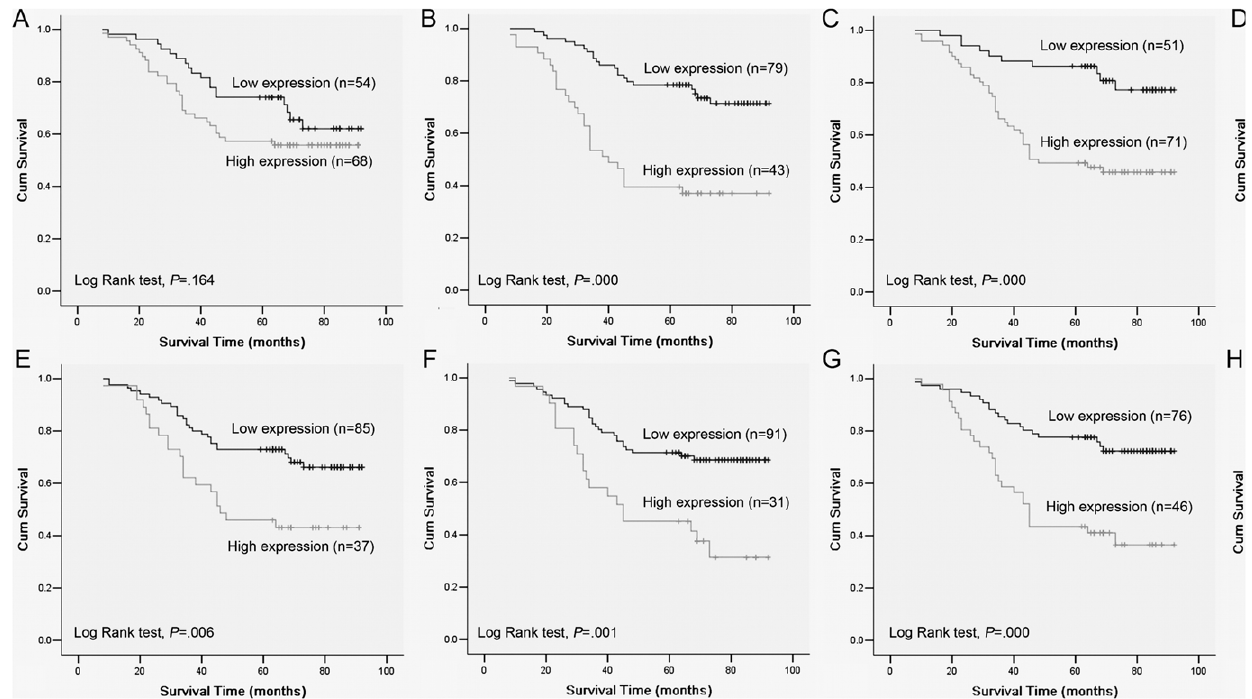
Figure 3. Influence of SOX2, OCT4 and Nanog expression on overall survival of NPC patients. There was no significant difference in the overall survival between low and high nuclear SOX2 expression(A). Patients showed worse overall survival with high nuclear OCT4 (B), cytoplasmic Nanog (C) and coexpression of OCT4 and Nanog (D) in tumors. Patients with high expression of nuclear SOX2 (E), nuclear OCT4 (F), cytoplasmic Nanog (G) and coexpression of OCT4 and Nanog (H) in the invasive front of tumors showed worse overall survival. P -values were calculated by log- rank test.